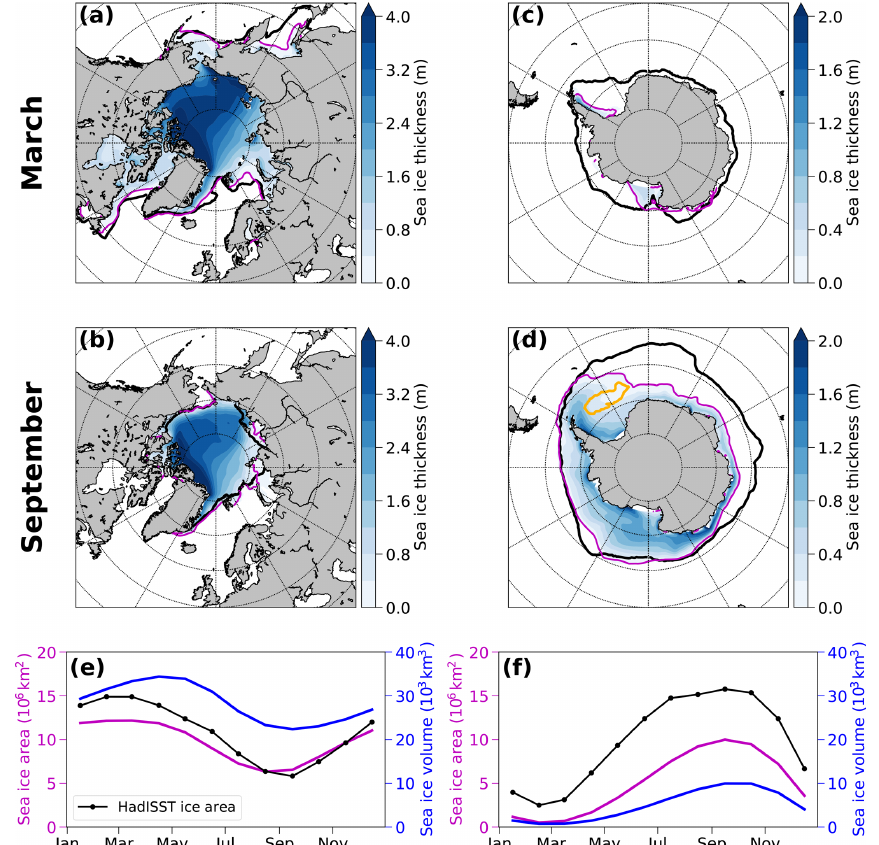
Figure 15. Average NH (a, b, e) and SH (c, d, f) sea-ice thickness, ice-edge position and annual cycles of total sea-ice area and volume are shown as 20-year means of a historical simulation (FOCI-hist1, 1980–1999). The ice edge is defined by the 15% sea-ice concentration contour shown as a magenta outline (a–d) . March and September means represent winter maximum and summer minimum spatial distri- butions for the Arctic and Antarctic (note that March is austral summer). In the area marked by a yellow outline in panel (d) , mixed layer depth regularly exceeds 1000m. Annual cycles of sea-ice area (magenta) and volume (blue) depicted in panels (e) and (f) are derived from monthly mean model output of the years 1980–1999. Observational estimates (HadISST, 1980–1999) of ice-edge position (a–d) and sea-ice area (e, f) are added as bold black